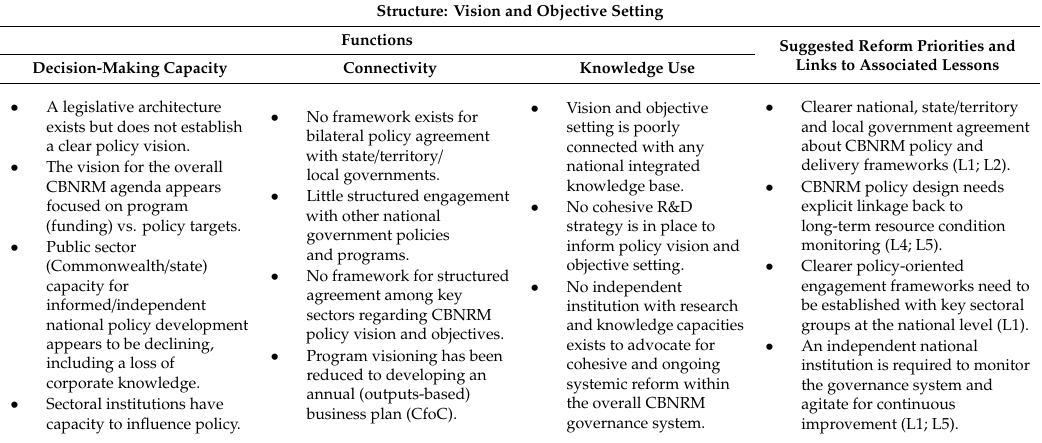
Table 2. A synthesis of findings regarding national aspects of vision and objective setting in Australia’s CBNRM governance system.